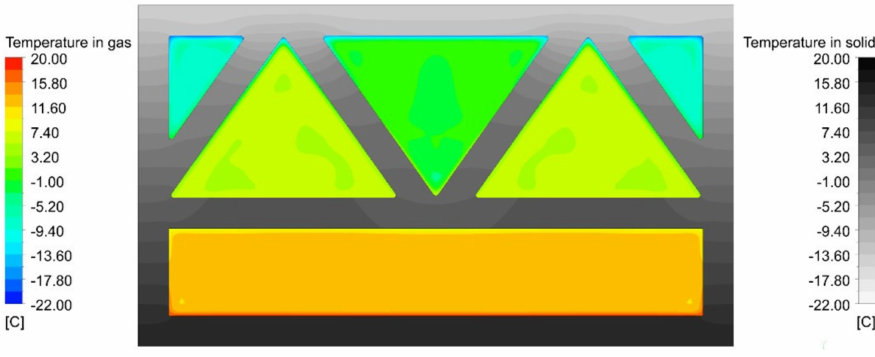
Figure 11. Wall heat flux through the construction. As all thermal characteristics change along with vertical coordinates because of natural convection, it is possible to take the middle cross-section plane to obtain an average change in values through the construction (Figure 12).